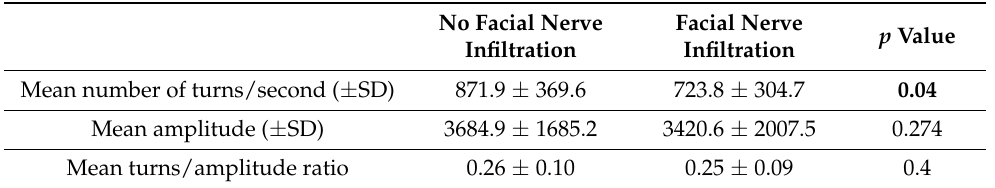
Table 4. Comparative analysis of the patient groups with and without infiltration of the facial nerve on the basis of data derived from the turns amplitude analysis. bold: statistically significant.